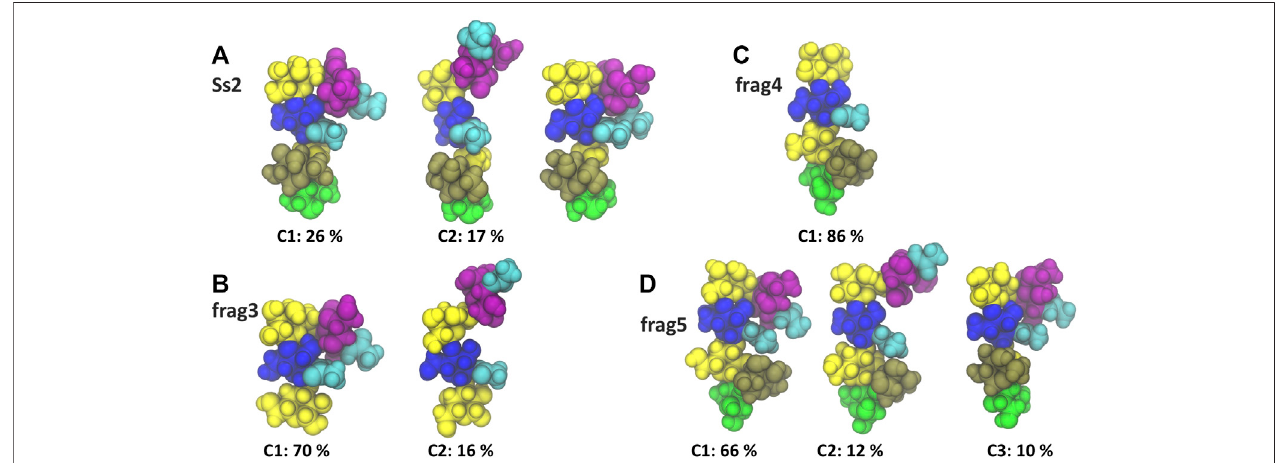
FIGURE 5 | Main conformational families and associated percentages of the sialic side chain in (A) RU 4 of Ss2 compared with the dominant conformation of the three Ss2 oligosaccharide vaccine candidates (B) frag3, (C) frag4 and (D) frag5 (Zhang et al., 2021). Conformational clusters with less than 10% occupancy are not shown.TheresiduesinallrepresentationsarecolouredinkeepingwiththeSNFG,asfollows: β D Galand β D GalNAc — yellow; α D Gal — brown; β D Glcand β D GlcNAc — blue; β L Rha — green; α D Neu5Ac — purple; NAc —